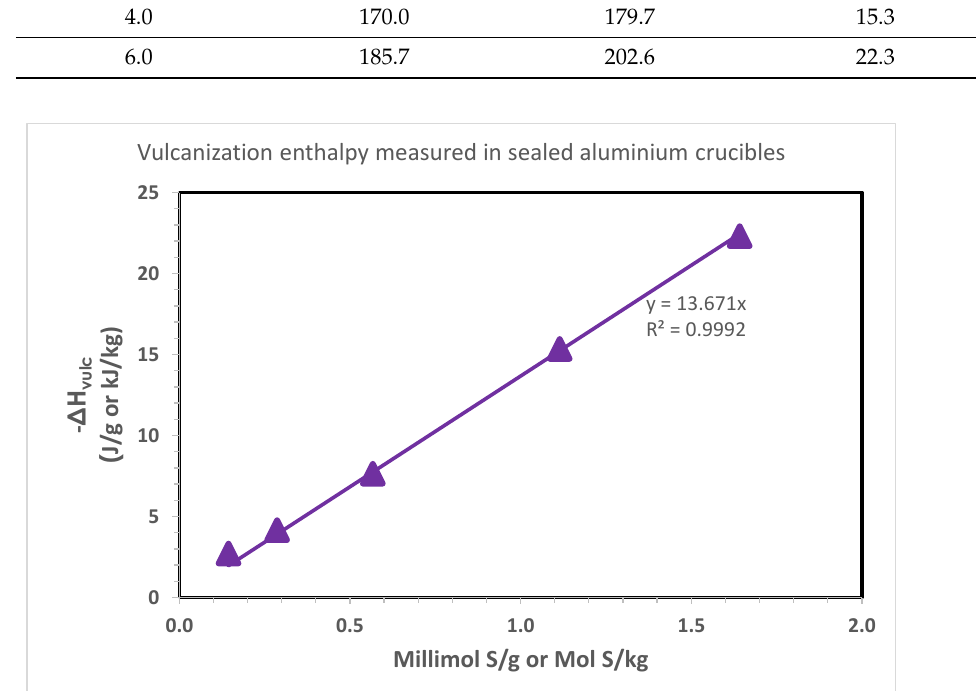
Table 2. Vulcanization enthalpy of NR-rubber compounds of reported in Table 1 heating rate 10 °C/min in sealed Al crucible.